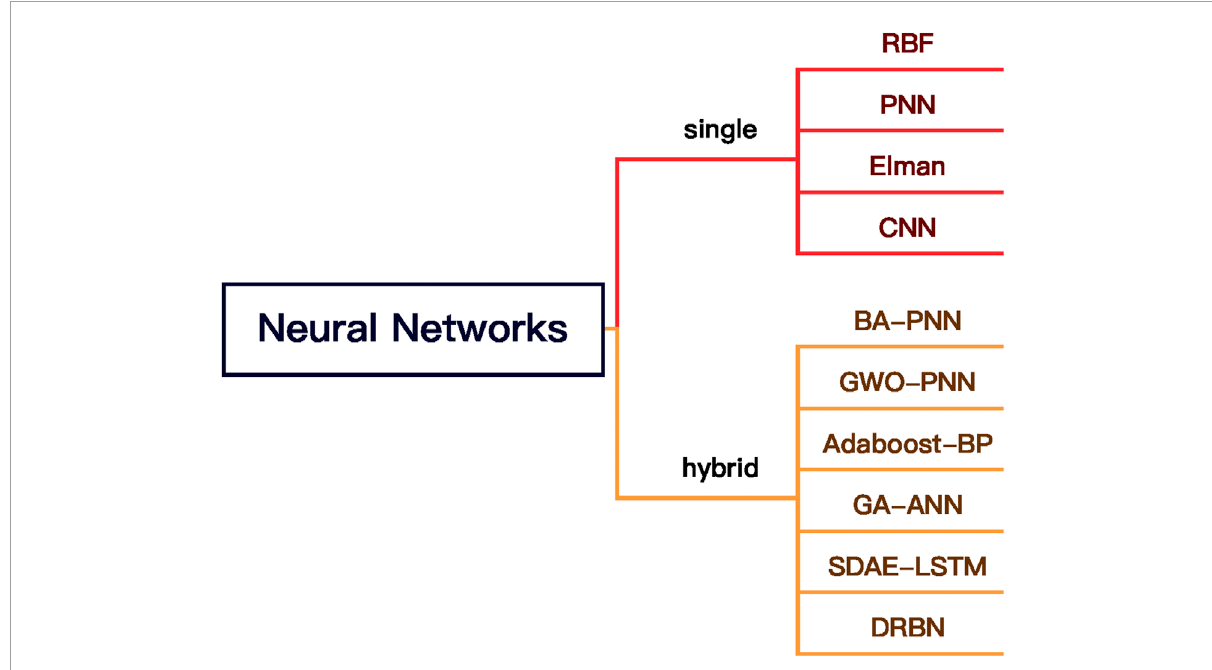
FIGURE 2 Using neural networks in order to improve the performance of fault